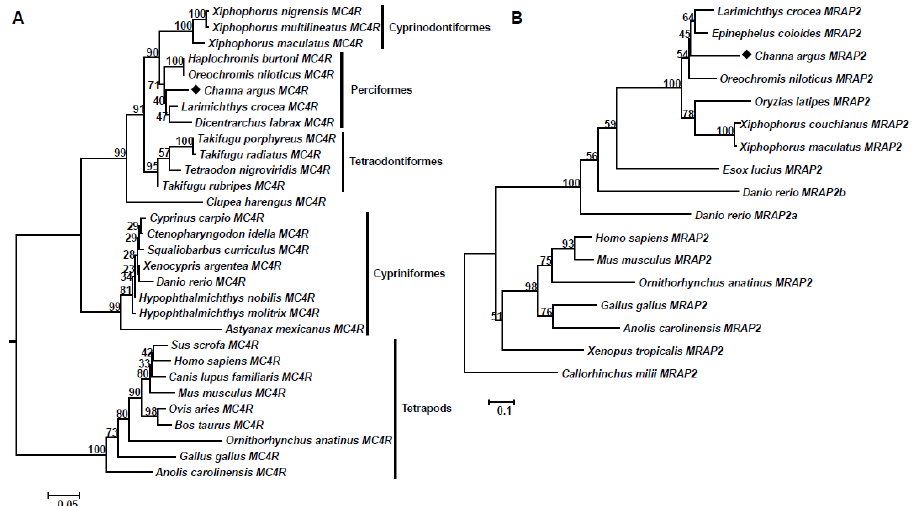
Figure 3. Phylogenetic trees of vertebrate MC4R ( A ) and MRAP2 ( B ). Both trees were constructed with MEGA 6.0 software based on protein datasets. The values at the nodes represented bootstrap percentages from 1000 replicates. The caMC4R and caMRAP2 were marked with a black diamond. The IDs of protein sequences used in present study were shown in Tables S2 and S3.